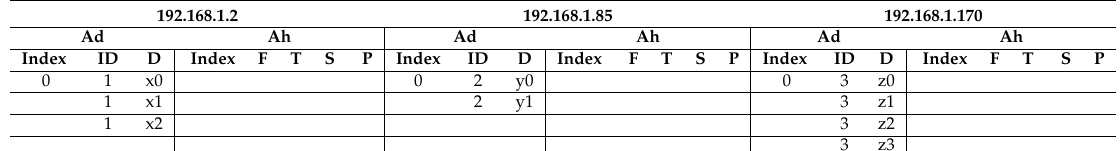
Table 2. History initialization with three agents.